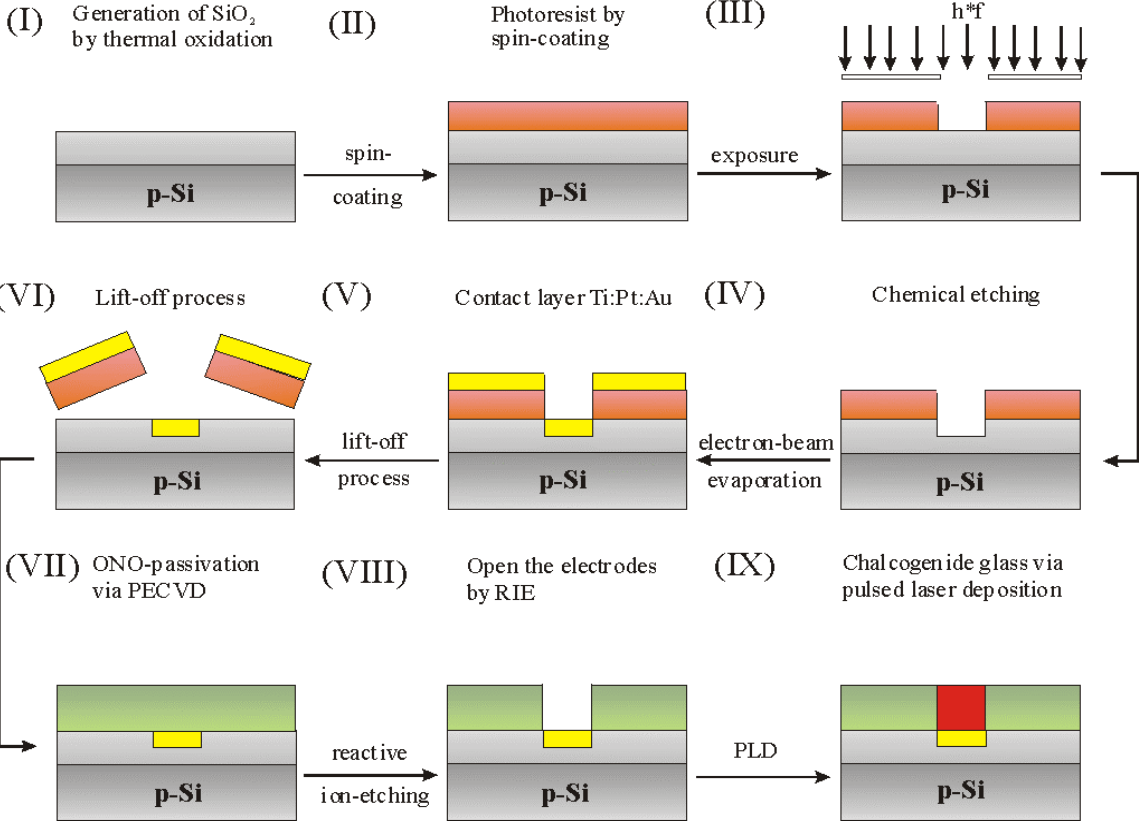
Figure 1 . Survey on the fabrication steps of the chalcogenide glass-based thin-film sensor array (I: thermal oxidation, II: spin-coating, III: exposure, IV: chemical etching, V: electron- beam evaporation, VI: lift-off process, VII: ONO passivation, VIII: RIE, IX: